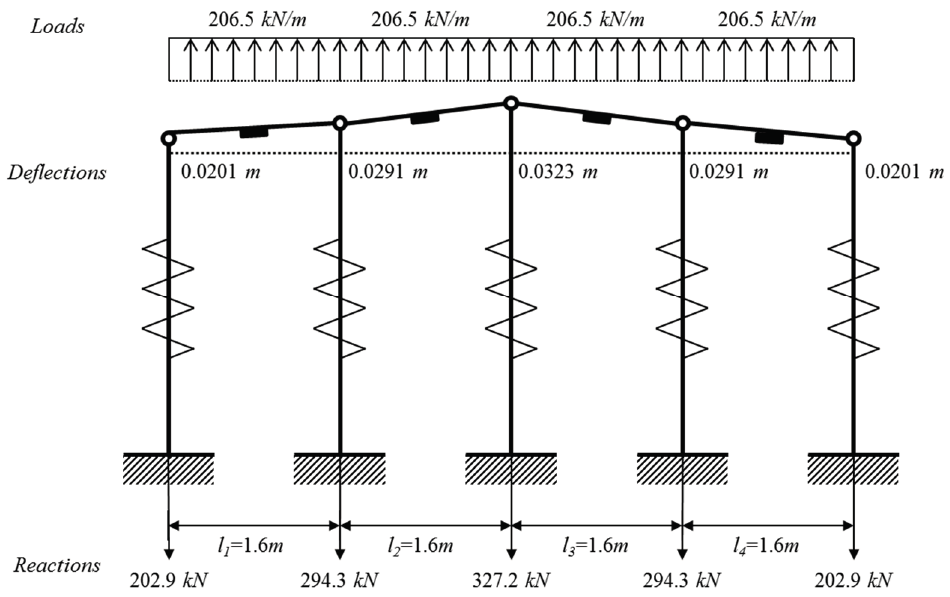
Figure 6. Deformed shape of 4-span beam subjected to the distributed lateral